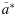
Schematics of the bio-optical approach used to quantify the rate of photons absorbed in photosystem II.First, the phytoplankton absorption spectrum (a(λ)) is normalized to the chl a concentration [a*(λ)]. Then, a*(λ) is weighted to the spectrum of the incubation light [E(λ)/EPAR] to give the spectrally-weighted chl a-specific light absorption (a¯*). Finally a¯* is corrected for the ratio of absorbed quanta in PSII (a*PSII:a*) to yield the PSII-specific light absorption coefficient [a¯*
PSII, m2 (mg chl a)−1]. See text for details.